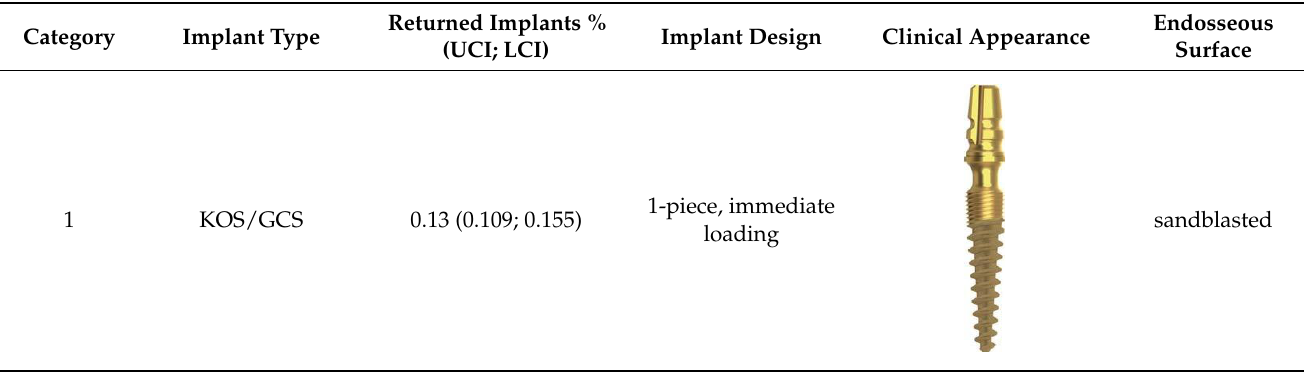
Table 1. Analysis of sold versus returned implants for various implant designs.